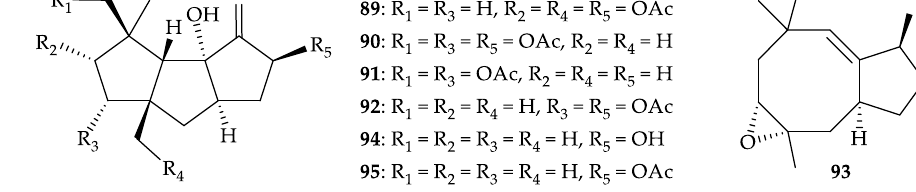
Figure 15. Structures of 2α,8β,13-triacetoxycapnell-9-ene-10α-ol ( 89 ), 3α,8β,14-triacetoxy- capnell-9- ene-10α-ol ( 90 ), 3α,14-diacetoxycapnell-9-ene-8β,10α-diol ( 91 ), 3α,8β-diacetoxy- capnell-9-ene-10α-ol ( 92 ), 3α,4α-epoxyprecapnell-10-ene ( 93 ), capnell-9-ene-8β,10α-diol ( 94 ), and 8β-acetoxycapnell-9-ene- 10α-ol ( 95 ).